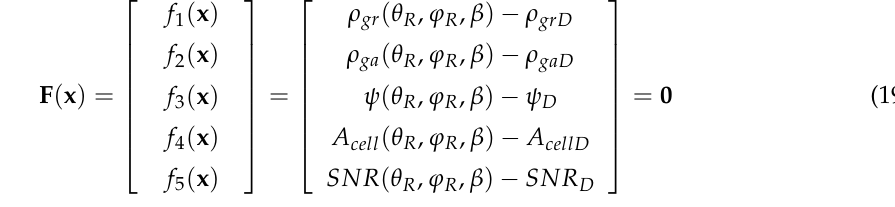
Figure 15. SNR with respect to θ R and ϕ R under HH